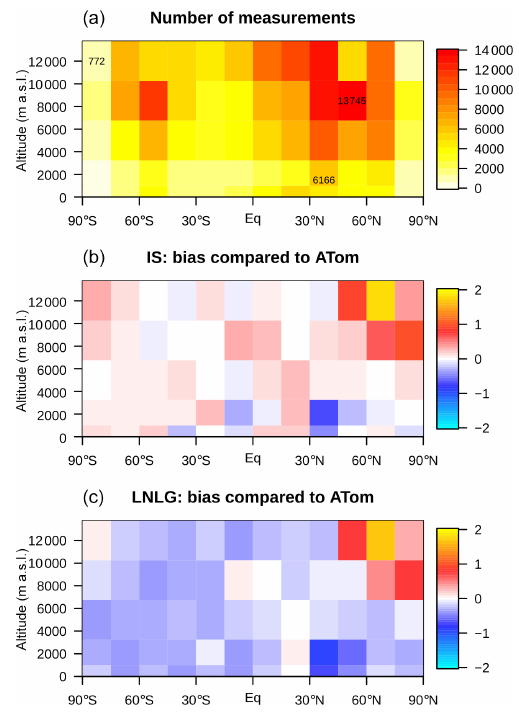
Figure 16. Comparison between ATom measurement samples and the MIP ensemble for the IS and LNLG experiments. The ATom samples have been binned into five altitude levels (going from the ground to 14km). Panel (a) shows the number of measurements for each bin. Panels (b) and (c) show, respectively, IS and LNLG ex- periment biases compared to ATom measurements. Biases are ex- pressed in ppm CO 2